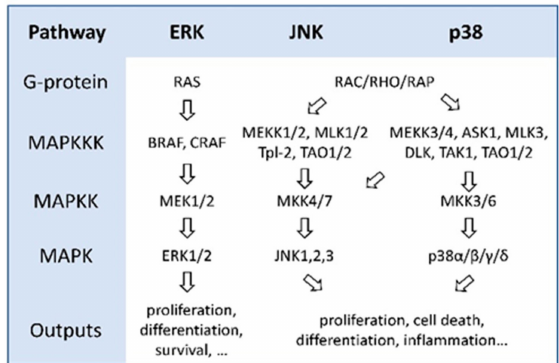
Figure 1. Organization of MAPK pathways. The MAPK core consists of three kinases (MAPKKK, MAPKK, and MAPK), which form a signal transduction cascade that receives input from G-proteins and produces di ff erent biological